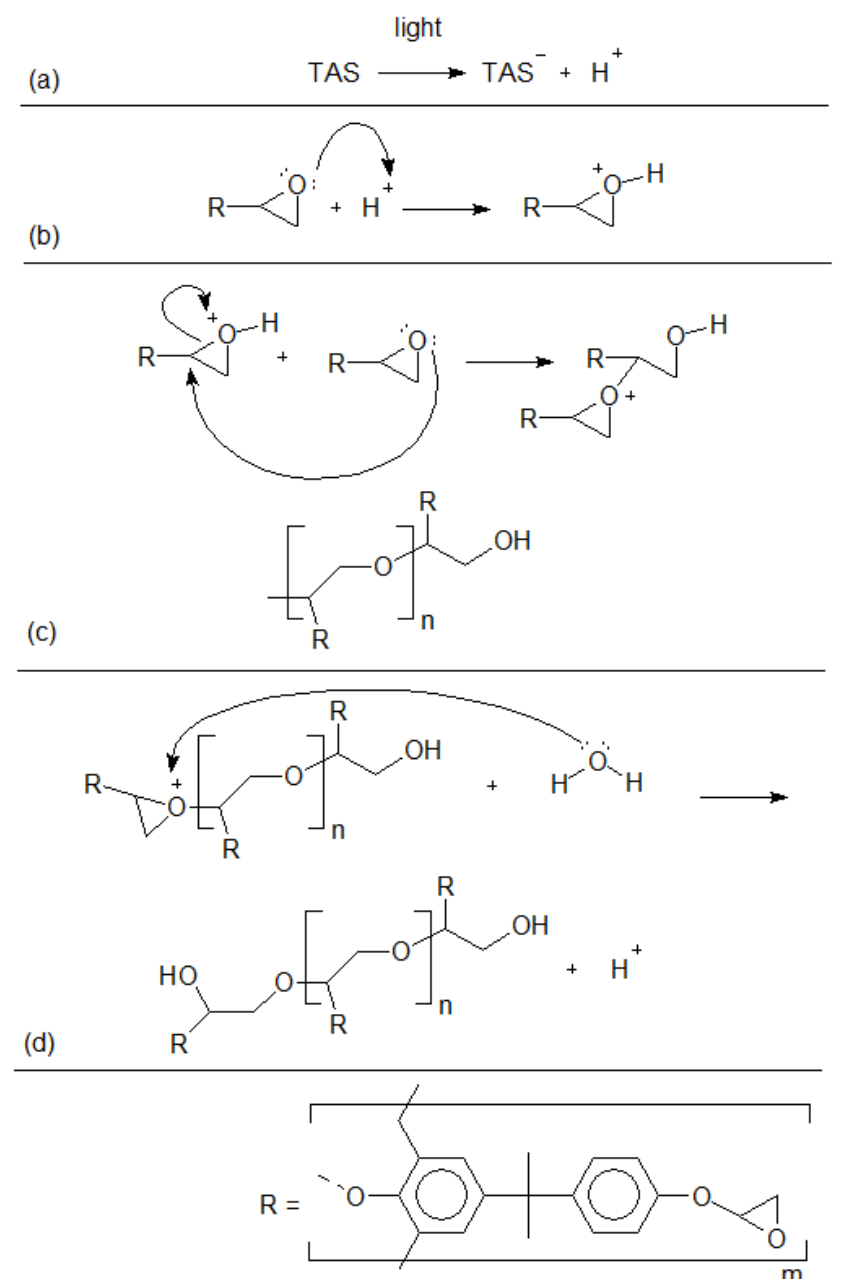
Figure 3. Aryl epoxy resin probable cross-linking reaction mechanism. ( a ) photoinitiator reaction with light. ( b ) epoxy group activation. ( c ) crosslinking reaction through epoxy groups. ( d ) epoxy group